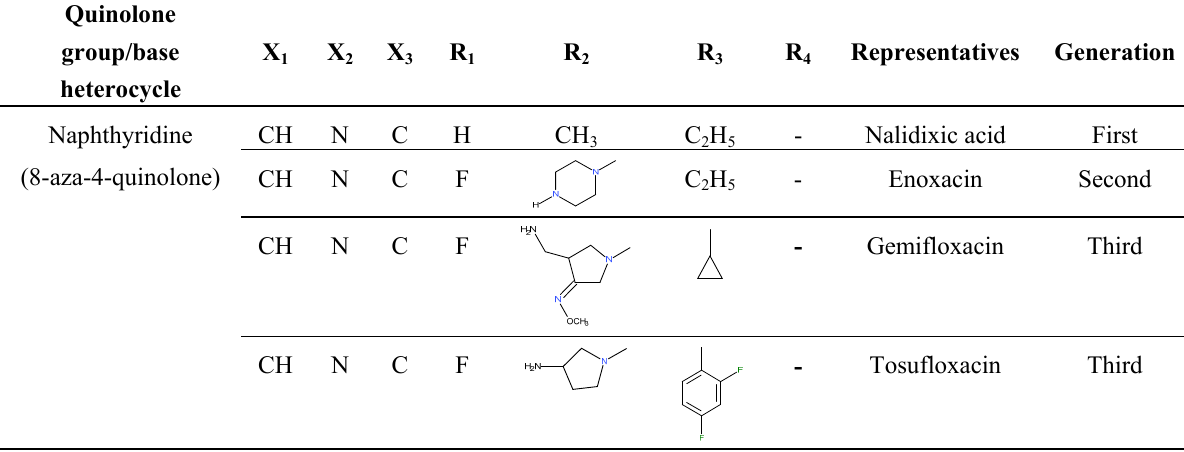
Table 1. Classes of quinolones based on chemical